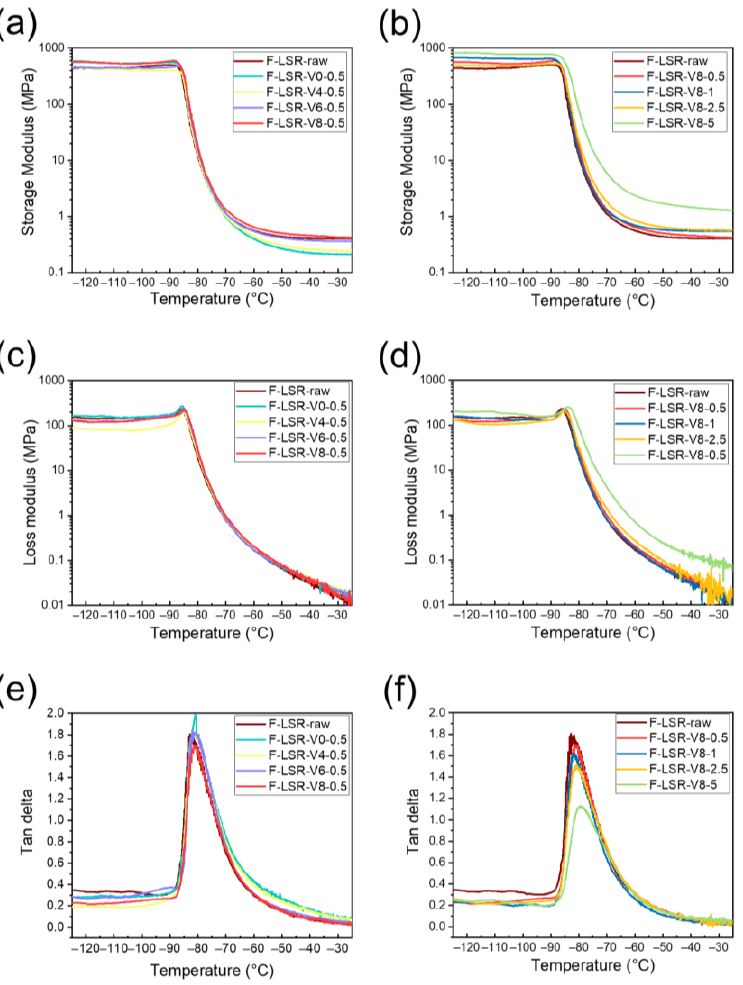
Figure 5. DMA analysis of all F-LSR-POSSs: ( a , b ) storage modulus; ( c , d ) loss modulus; and ( e , f ) tan delta.